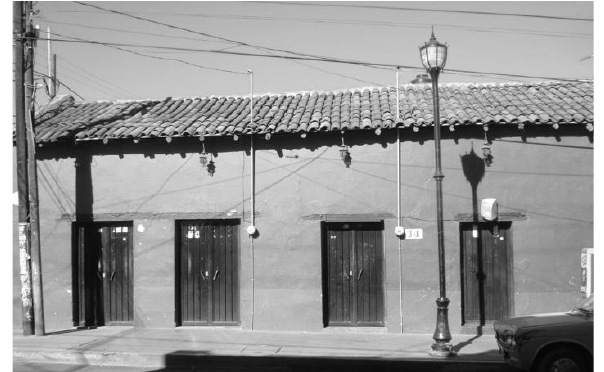
Figure 7. Type of facade simple in vernacular housing. (Source: DSRO).